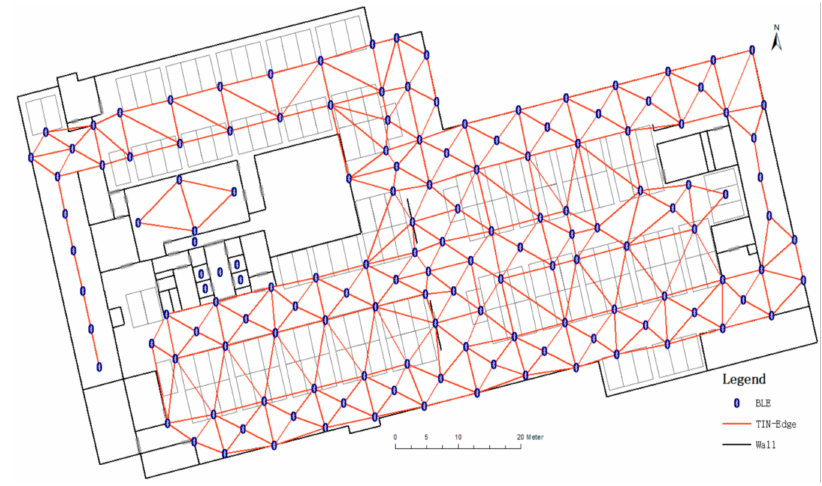
Figure 6. Virtual area